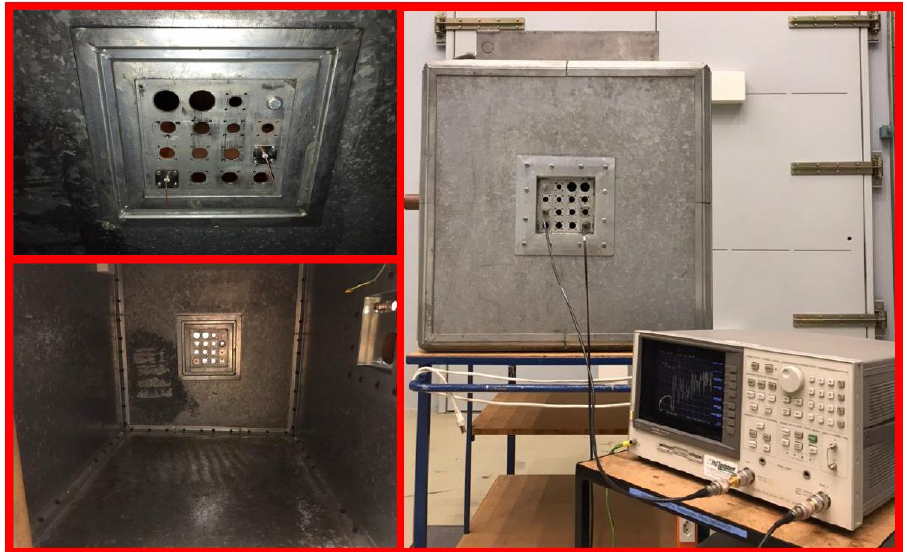
Figure 12. Experimental setup including the location of the antennas, the interior side of the cavity considered as the transformer tank, and the Vector Network Analyzer (VNA) that is used to measure the scattering parameters.